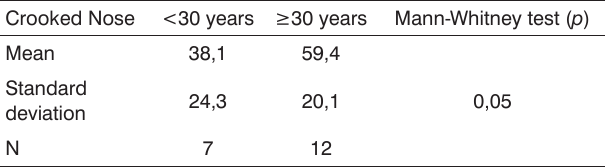
Table 4. Mean value of the pre and postoperative satisfaction scores of patients submitted to rhinoplasty to correct a crooked nose according to follow up